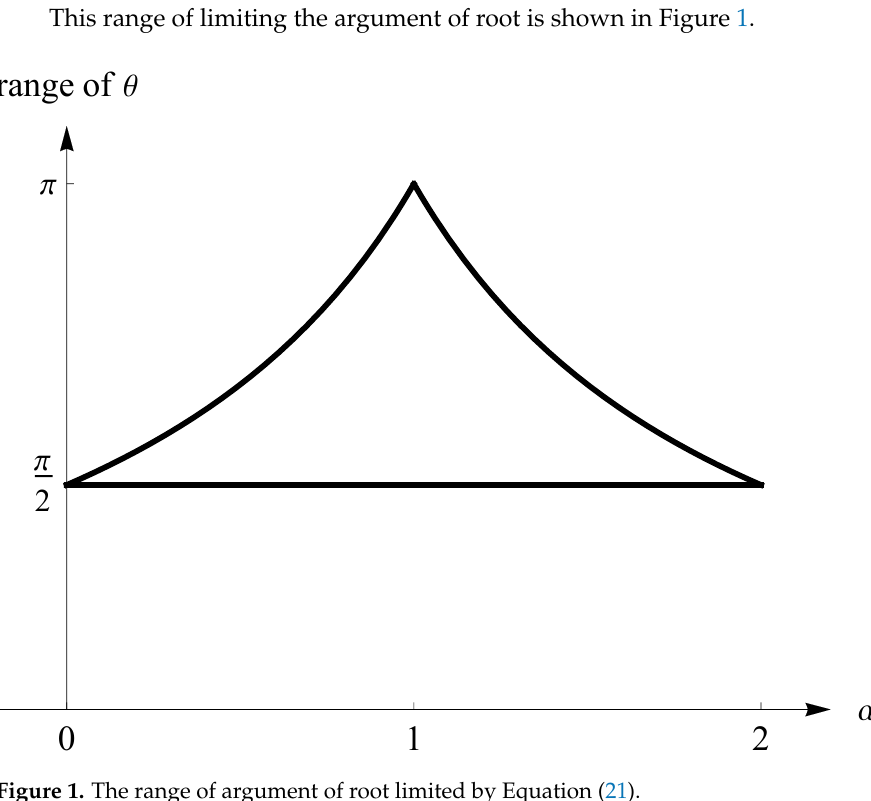
Figure 1. The range of argument of root limited by Equation